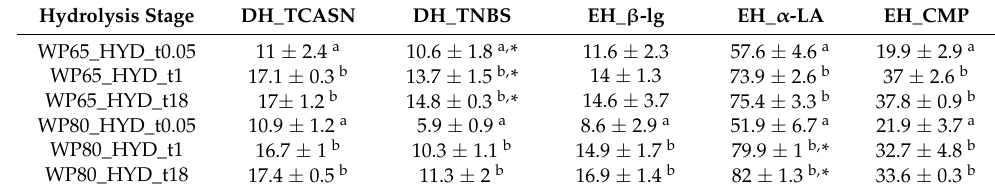
Table 4. Degree of hydrolysis (DH) and extent of hydrolysis (EH) estimated as described in Section 2.2.2. Abbreviations explained in Section 2.2.4 and Table 1. Means and standard devia- tions of three